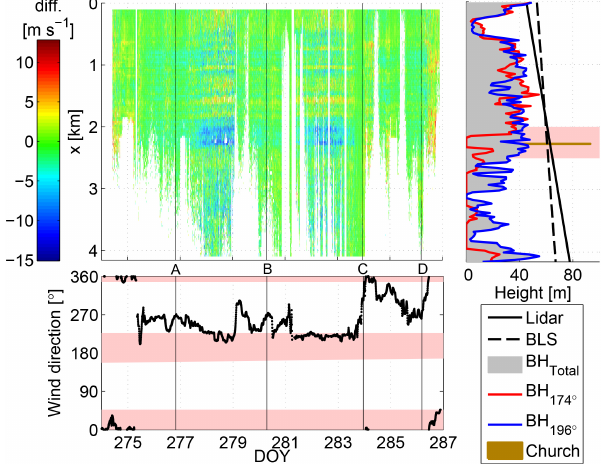
Figure 2. The upper left panel shows the difference in U ⊥ estimated by the Doppler lidar duo-beam method compared with Anemome- ter South (colour-bar, Doppler lidar minus sonic anemometer) as a function of lidar beam distance (resolution of 30m) and time (reso- lution of 10min, DOY: day of year). A–D are cases (Table 1). The right panel shows the height (ma.s.l.) of the lidar beam and build- ing height (BH) ± 25m laterally underneath the paths (total, and under beam with azimuth 174 and 196 ◦ ). When there are no build- ings below the path, BH indicates the height of highest ground point or zero when it is over sea. The lower panel shows wind direction against DOY from Anemometer